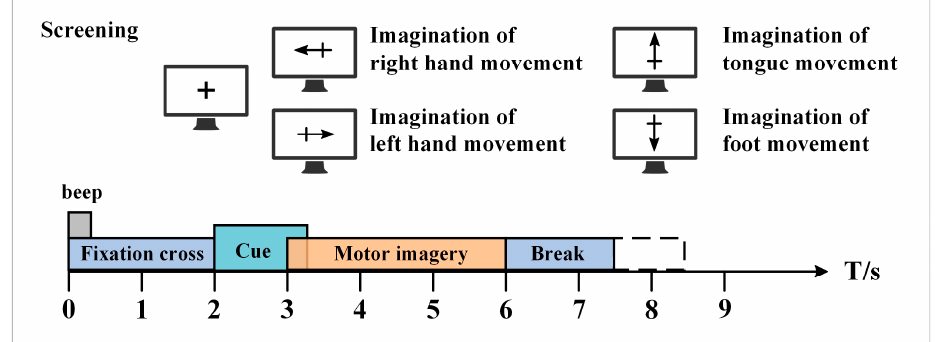
Figure 5. Electrode montage corresponding to the international 10–20 system. Table 2. The details of the experimental dataset.